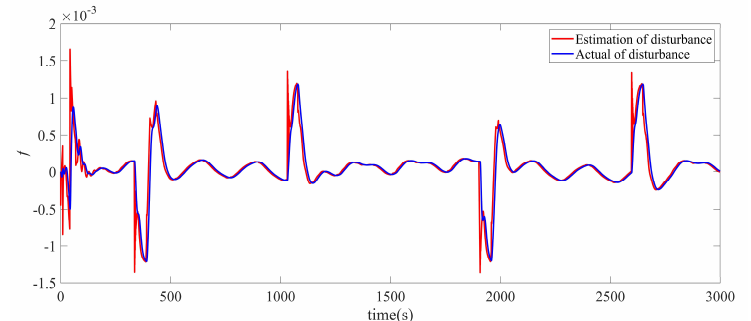
Figure 10. Estimation of disturbance and actual disturbance.